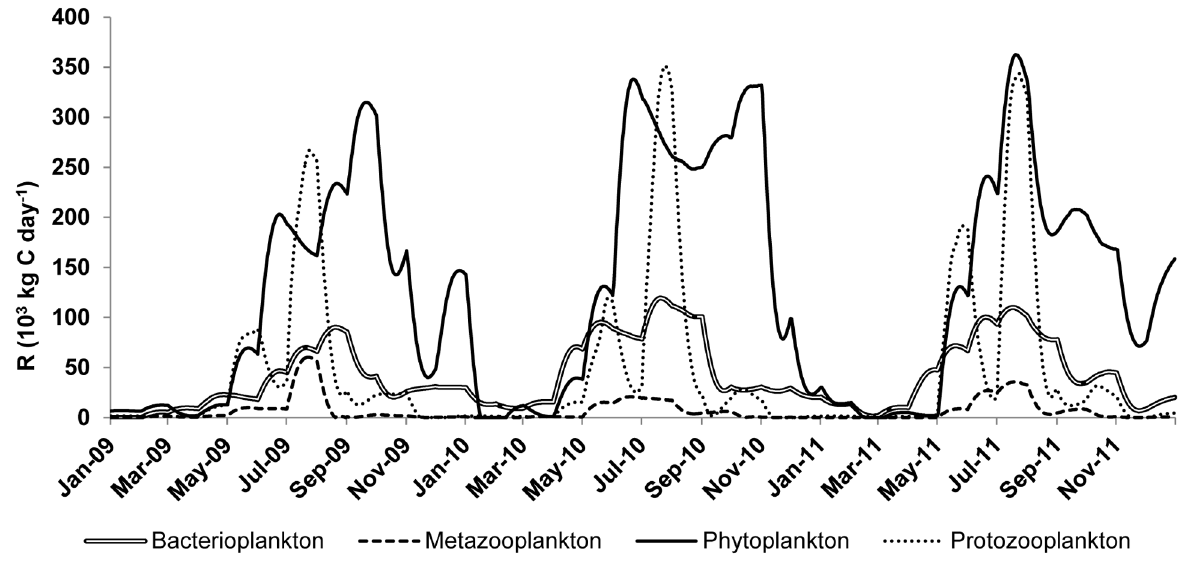
Figure 5. Calculated lake-wide respiration (10 3 kg C day 2 1 ) of benthic functional groups during the 2009 – 2011 period.